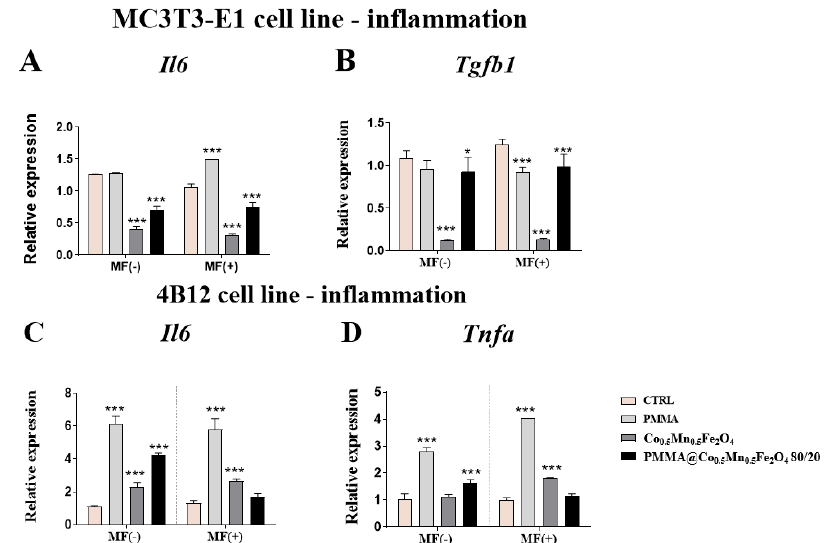
Figure 10. The impact of PMMA and its modification on the expression of genes related to inflam- mation profile under the magnetic field condition towards mouse pre-osteoblasts (MC3T3-E1 cell line) Il-6 ( A ), Tgfb1 ( B ) and mouse pre-osteoclasts (4B12 cell line) Il-6 ( C ) and Tnfa ( D ). Statistical differences are indicated by * p < 0.005; and *** p < 0.0001.